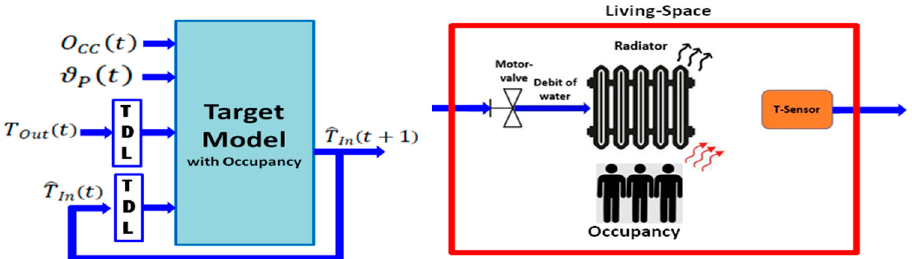
Figure 2. Proposed identification architecture of the target heating model ( left side ) and general diagram of the modeled Living Space, including the influence of its occupancy ( right side ). TDL: tapped delayed line, Occ : occupation, Vp : valve position, T : temperature.